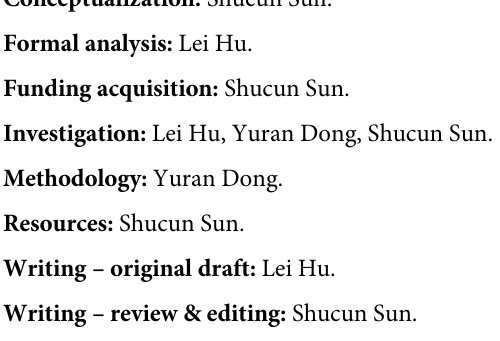
Fig 3. The linear regression between observed and predicted interaction frequency based on the relative species abundance. The solid lines show the fit of a quadratic model and the 95% confidence